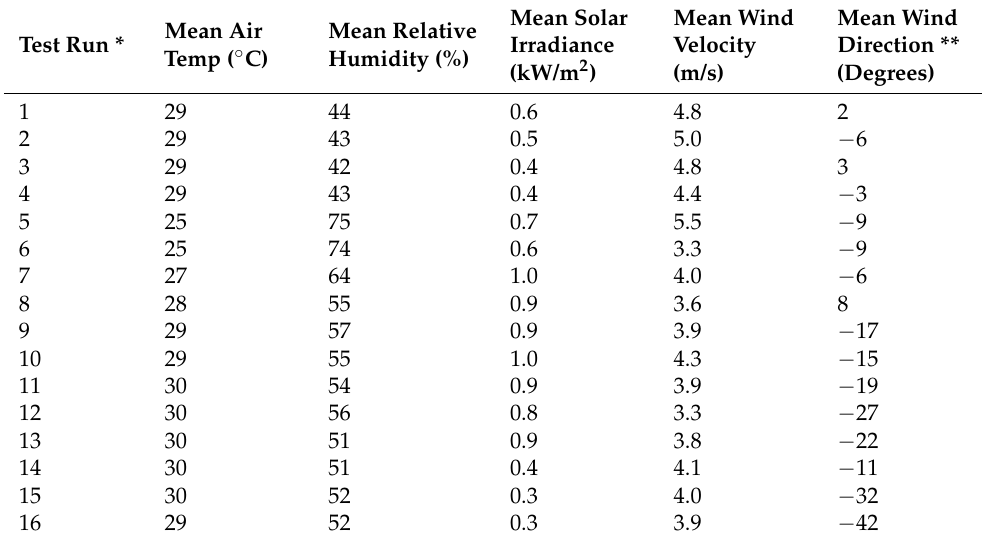
Table 1. Meteorological data obtained during the spray